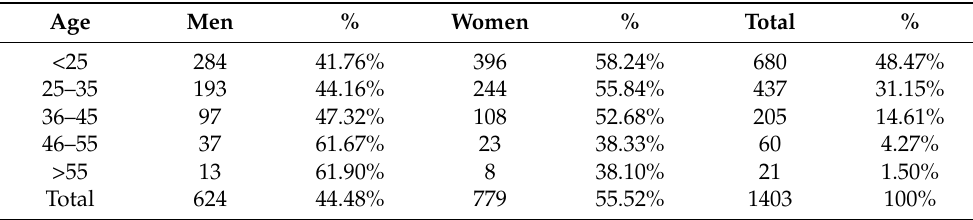
Table 1. Details of the